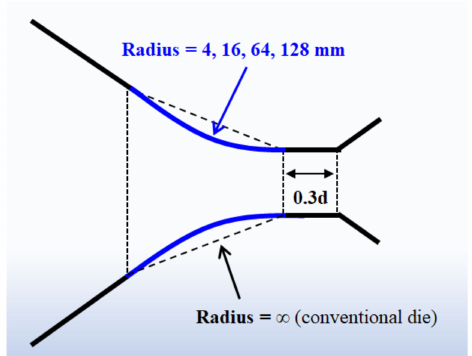
Figure 3. Schematic explanation of die geometry used in this study.